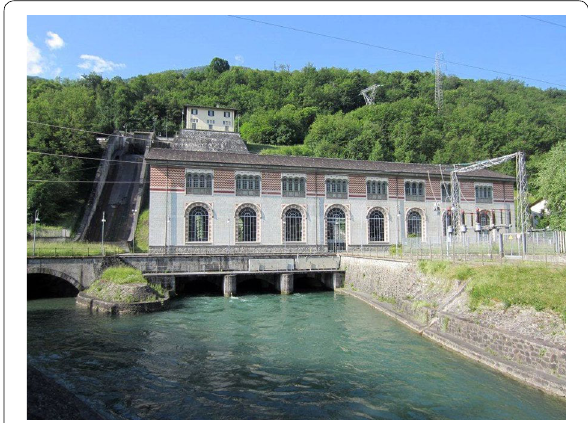
Fig. 4 Historical hydropower plants: in this case Valchiavenna (from www.sondr iotod ay.it)